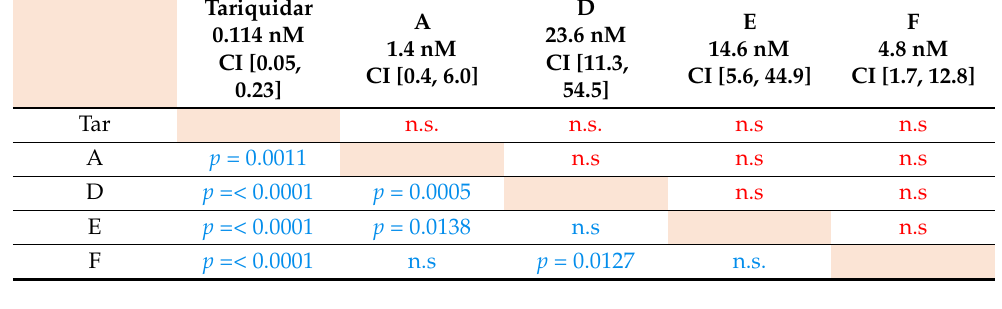
In contrast, compounds ‘E’ and ‘F’ at 100 nM concentration did kill cells over the three- day period.